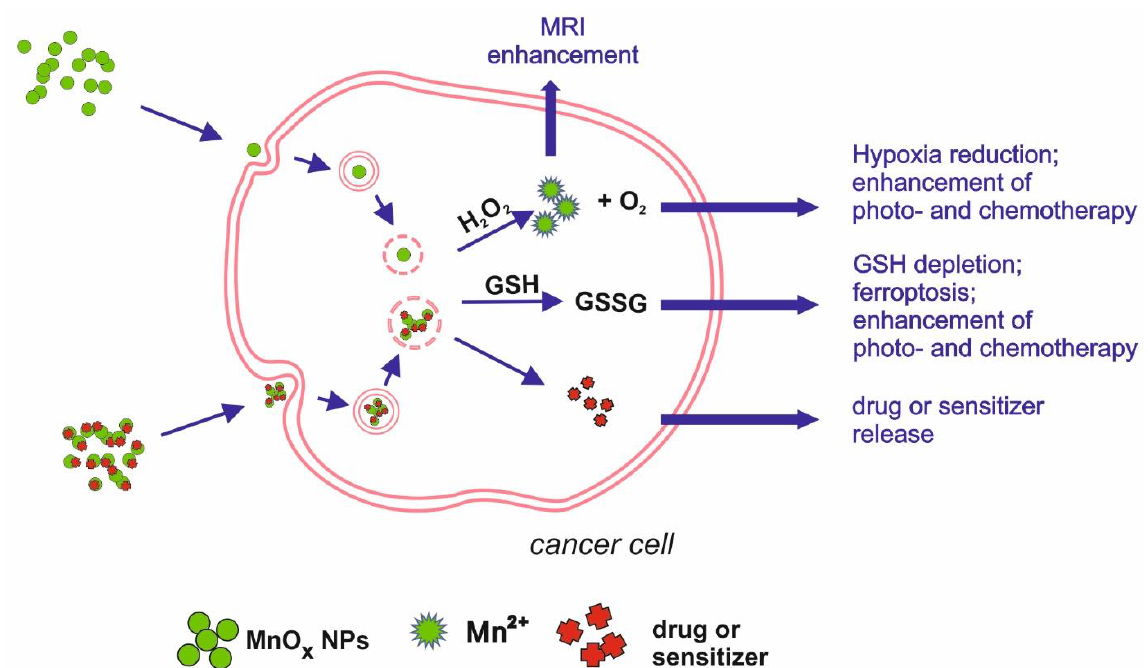
Figure 2. Schematic illustration of main mechanisms underlying manganese oxides medical applications. Table 1. Summary of potential medical applications of manganese oxides in nanoform.